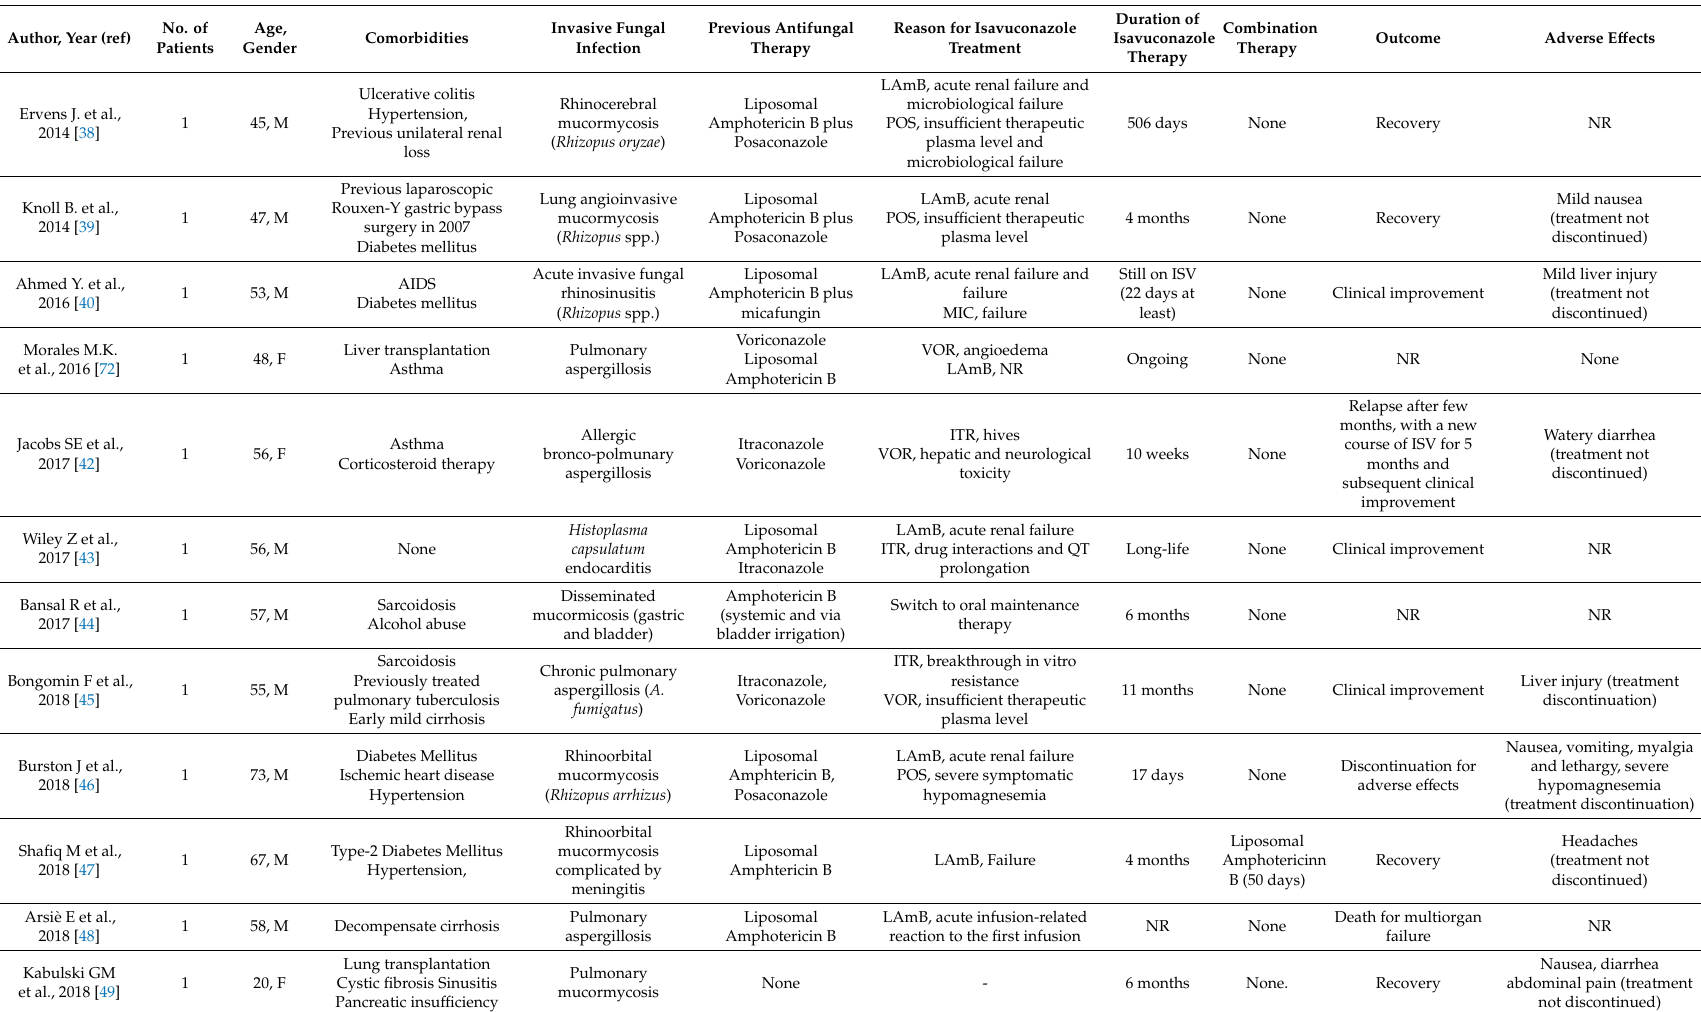
Table 2. Isavuconazole treatment in non-hematological patients with invasive fungal